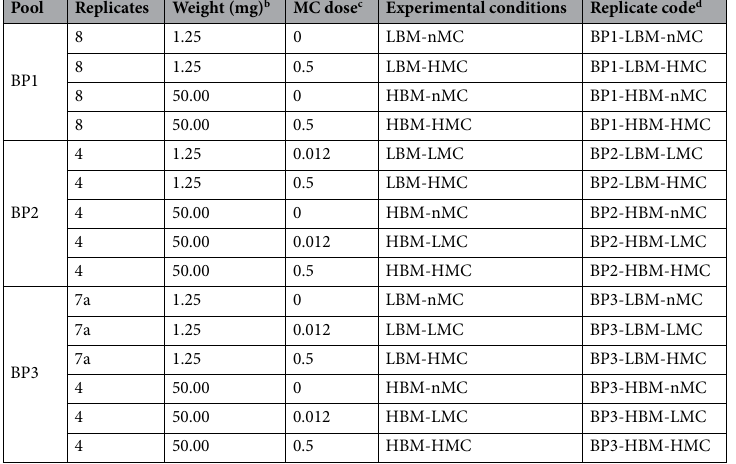
Normalization strategy Distance Pool ID